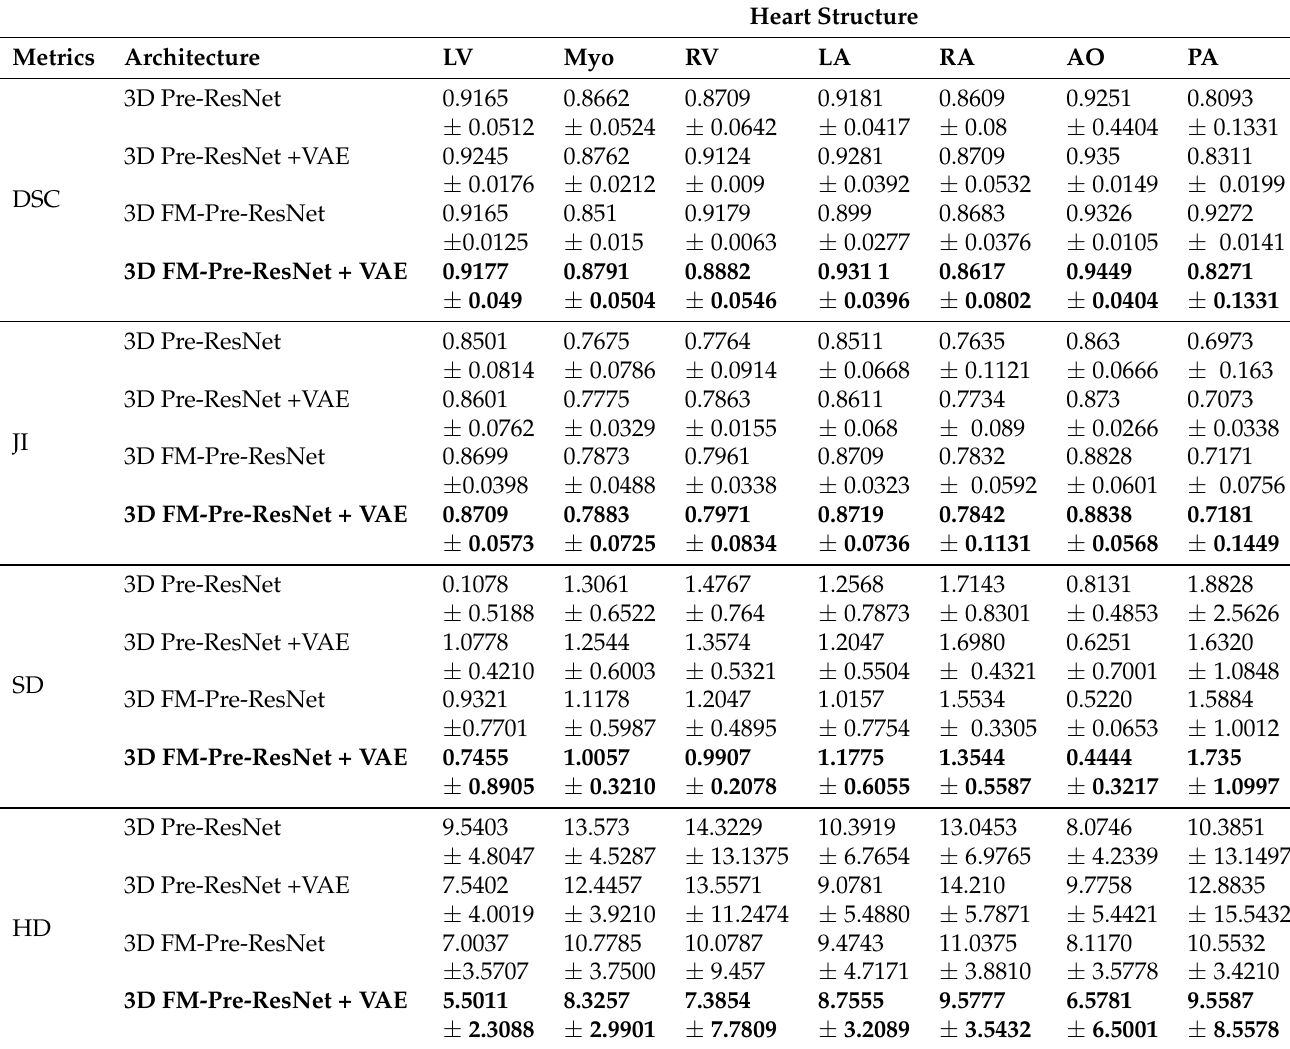
Table 3. Structure-wise DSC evaluation of proposed architecture and other 3D based architectures in terms of DSC, JI, HD, SD on CT testing dataset for LV, RV, LA, RA, Myo, Ao, and